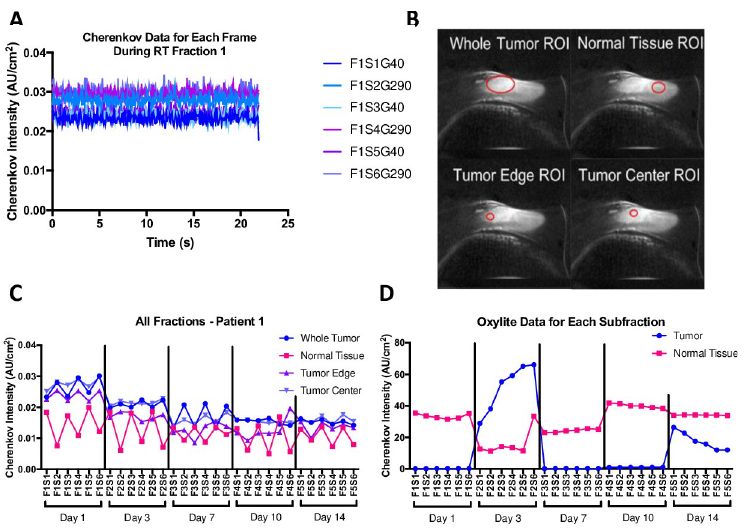
Fig 4. Example data from canine subject #1. A) For the whole tumor ROI, the Cherenkov intensity was measured for each frame, normalized to 1/R 2 and plotted against time. The legend denotes fraction 1 (F1), subfractions 1–6 (S1-S6), and gantry angles 40˚ and 290˚ (G40 and G290). Over time, each of the frames is consistent, suggesting that average Cherenkov information for each subfraction is a good representative of the data. B) For canine 1, fraction 1, subfraction 1, gantry angle 40˚, the ROIs are drawn in red around the whole tumor, normal tissue, tumor edge and tumor center. C) For the same dog, the averaged value for each subfraction is recorded with the standard error of the mean as the error bars. The vertical black bars denote different fractions on different days. D) Similarly, the Oxylite data is shown for both the tumor and normal tissue over the course of the entire treatment. Each data point represents the mean Oxylite value for a